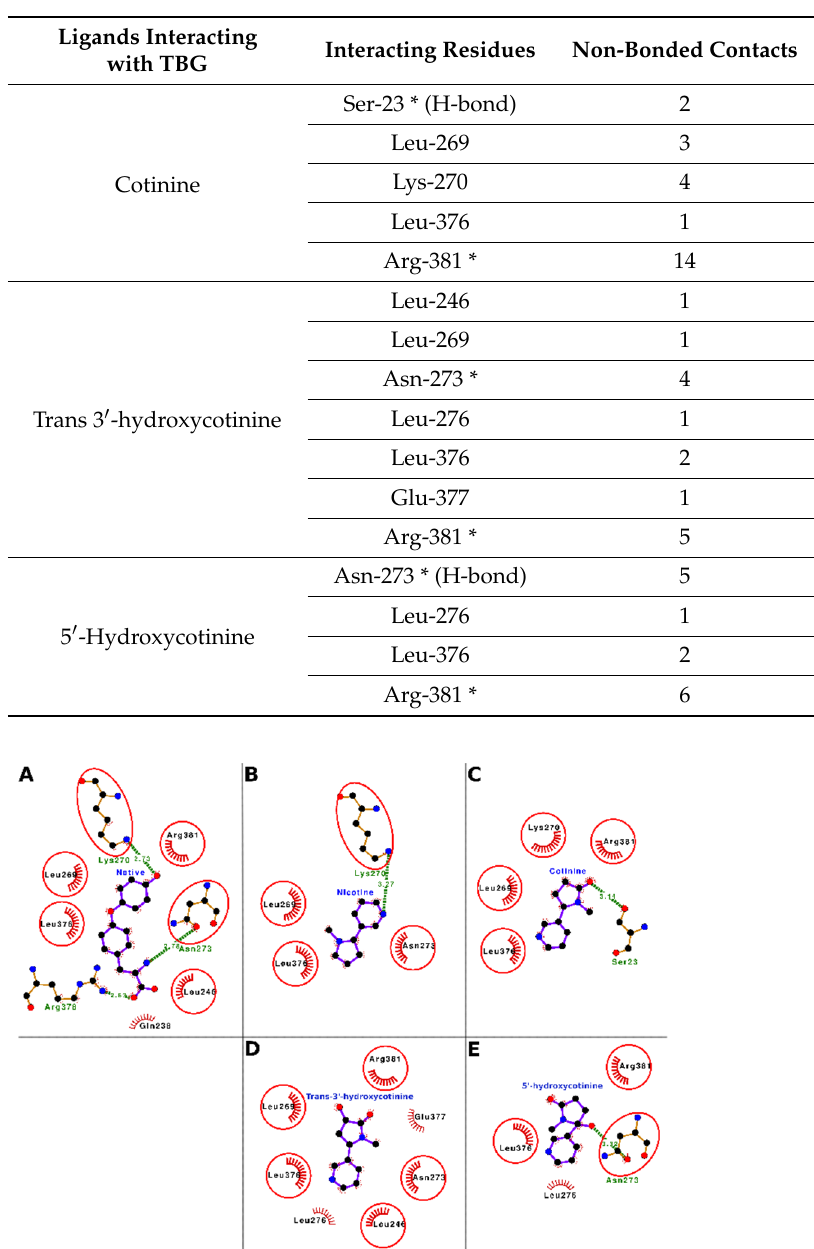
Figure 8. Ligand–protein interaction plots of the native ligand (thyroxine; Panel A ), nicotine (Panel B ), cotinine (Panel C ), trans-3 ′ -hydroxycotinine (Panel D ), and 5 ′ -hydroxycotinine (Panel E ) in complex with thyroxine-binding globulin (TBG). The ligands are placed at the center of each plot surrounded by the interacting residues. The ligands and the residues forming hydrogen bonds are shown in the ball and stick representation. The balls represent the atoms, and the sticks represent the bond between them. The color of the balls differentiates the atom types, i.e., the black balls rep- resent carbon atoms, red balls oxygen atoms, and blue balls nitrogen atoms. The hydrogen bonds are shown as green dashed lines labeled with bond length (in Å). The residues forming nonbonded contacts are shown as arcs with bristles. The interacting residues for ligands which are common with the interacting residues for the native ligand are encircled.